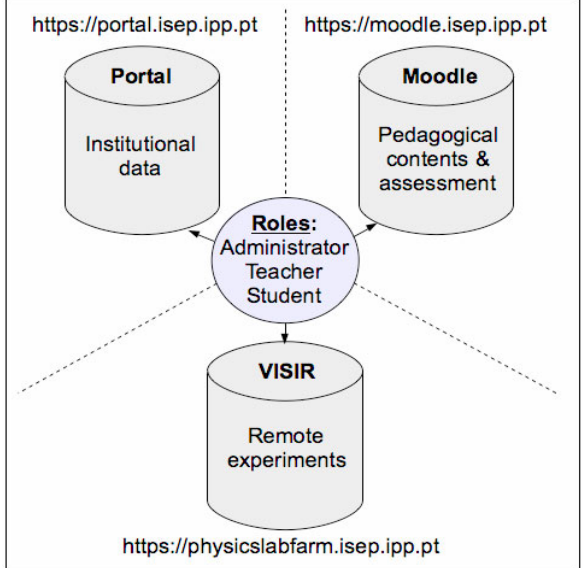
Figure 1. Sites used for institutional and teaching and learning pur- poses at ISEP tween these two components, i.e. if individuals log into Portal and later need to check something on Moodle,